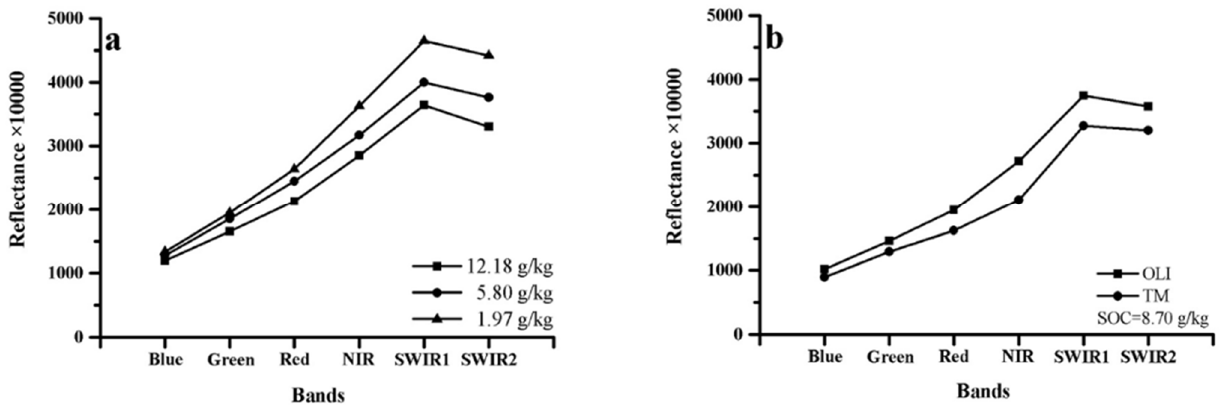
Figure 2. ( a ). Reflectance characteristics of different SOC values of OLI. ( b ). Comparison of spectral characteristics between OLI and TM.